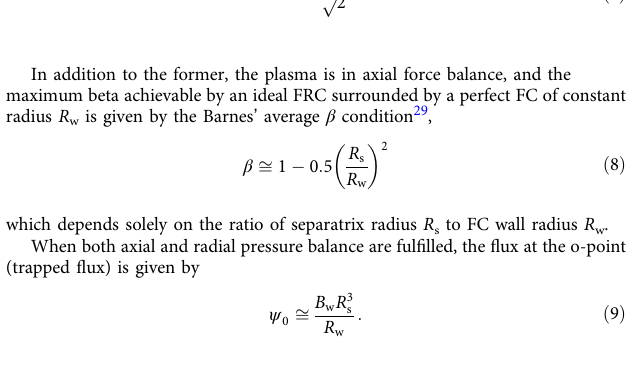
Fig. 5 Inference of Alfvenic oscillations. a Hooke ’ s constant as obtained from the inferred magnetic con fi guration. b Estimated particle inventory as stored in the C-2U database. c Electromagnetic force (solid green), plasma mass times acceleration (red) and Hooke ’ s constant times axial plasma displacement (blue). The shaded area corresponds to one